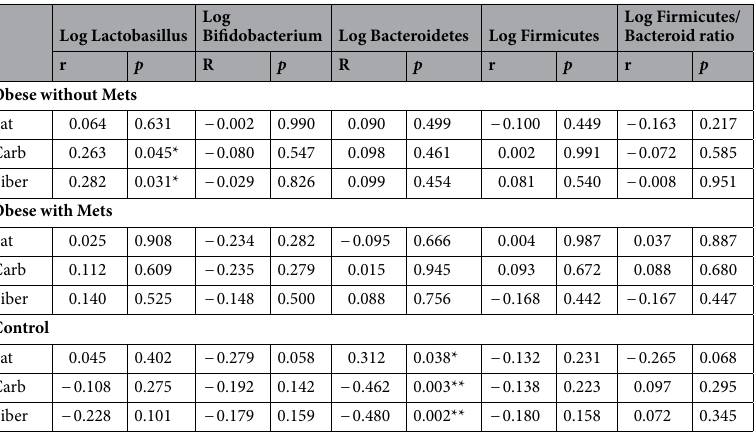
Table 7. Pearson’s correlation coefficient between gut microbiota and daily intake of total fat, carbohydrate and fiber of the studied groups. Significance difference * p ≤ 0.05, ** p ≤ 0.01.